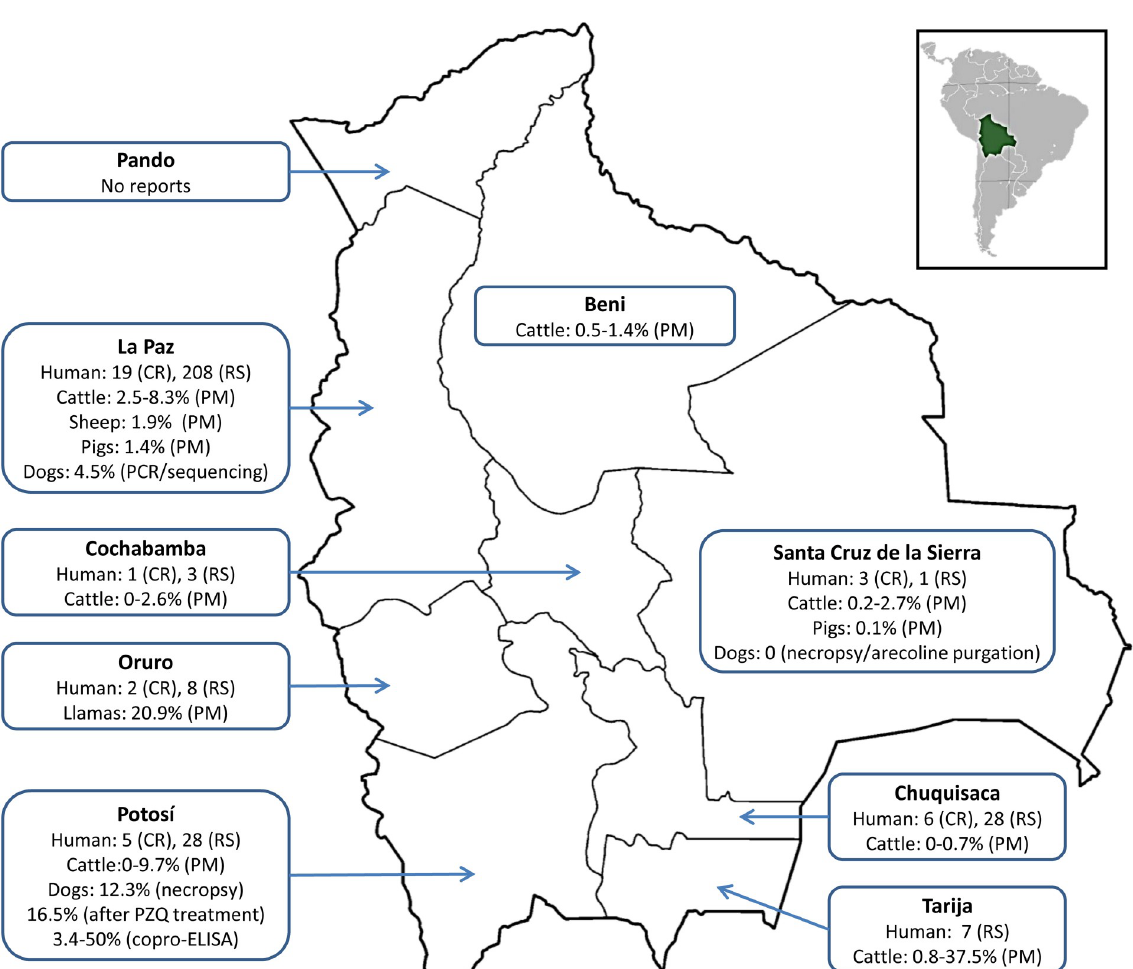
Fig 1. Distribution of human CE cases in Bolivia reviewed in this study from case reports and retrospective studies; maximum and minimum prevalence recorded in livestock at official postmortem examination at abattoir; and in dogs established at necropsy, arecoline purgation, after treatment with praziquantel, copro-ELISA, and PCR/sequencing. In total, there are 38 human case reports (for 2 cases, the origin is unknown) and 517 cases from retrospective studies; only 284 cases were included in the figure due to the lack of information about the origin of the patients. Original base layer of the map can be found here: https://commons.wikimedia.org/wiki/File:Bolivia_departments_blank. png. CR, case report; PM, postmortem; PZQ, praziquantel; RS, retrospective study.